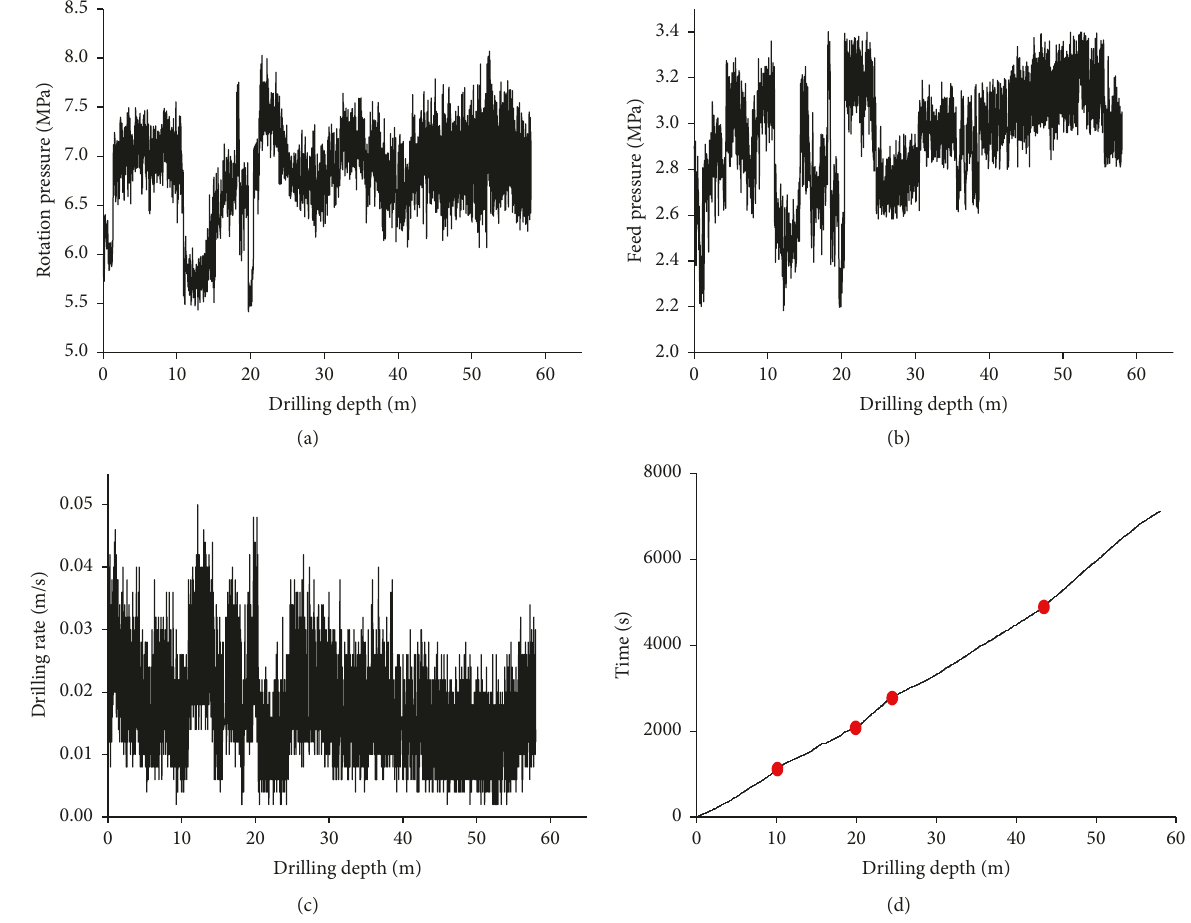
Figure 10: Monitored curves in No. 22